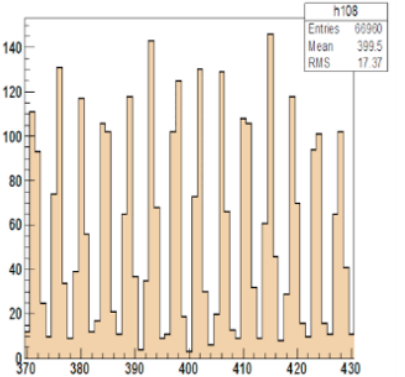
Figure 4. Bunch structure in TDC counts as seen by one HET station. The detector time resolution is good enough to disen- tangle the bunch spacing. This is a measurement performed by illuminating the HET station with an electron beam at the Fras- cati Beam Test Facility.